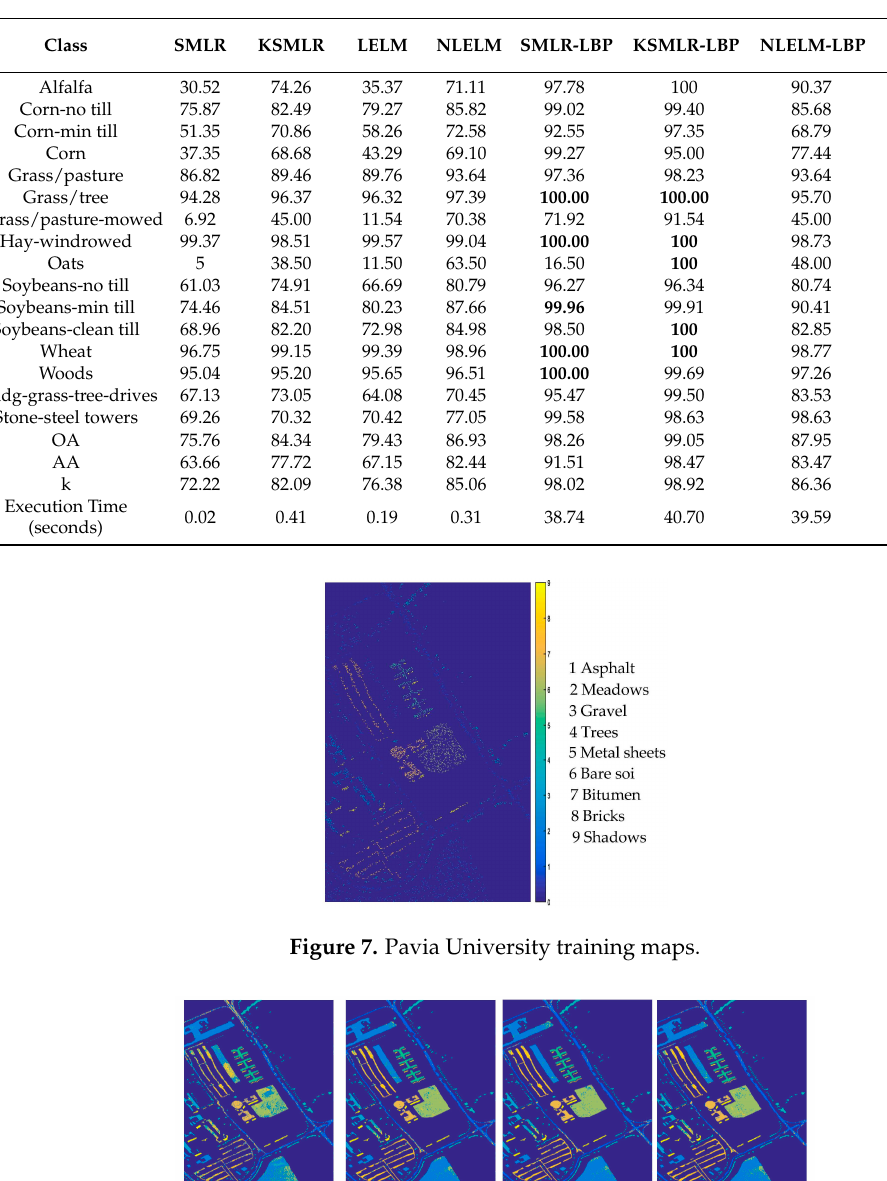
Table 2. Indian Pines: overall, average, and individual class accuracy (in percent) and k statistic of different classification methods with 10% training samples. The best accuracy in each row is shown in bold.